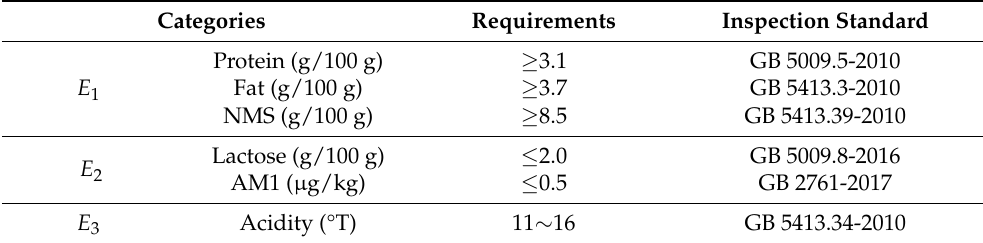
Table 1. The sample feature set. Categories